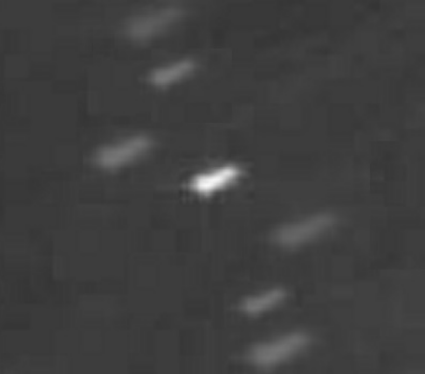
Figure 22. SAR image of ship acquired from the backscattered signals of ships on the Strait of Dover, acquired with TerraSAR-X